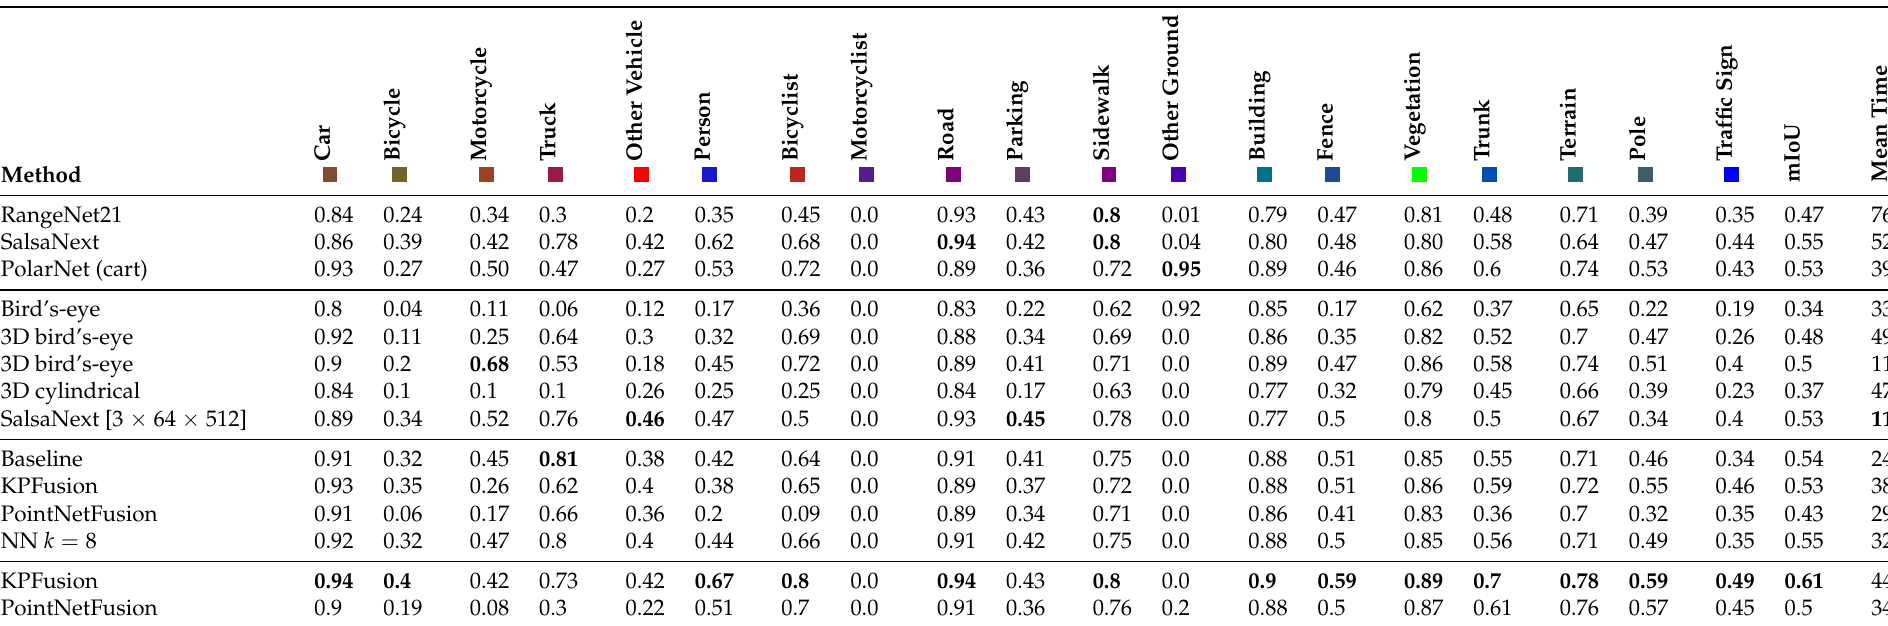
Table 6. Results of SemanticKITTI validation split. Section 1 shows relevant state-of-the-art methods and their results. Section 2 shows our single projections. The fusion approaches are shown in Sections 3 and 4. Note that the values differ from the published values. This is because the validation data has been used, and there is no post-processing. For the fusion approach, the NN calculation is included within the inference time, and the architectures are not